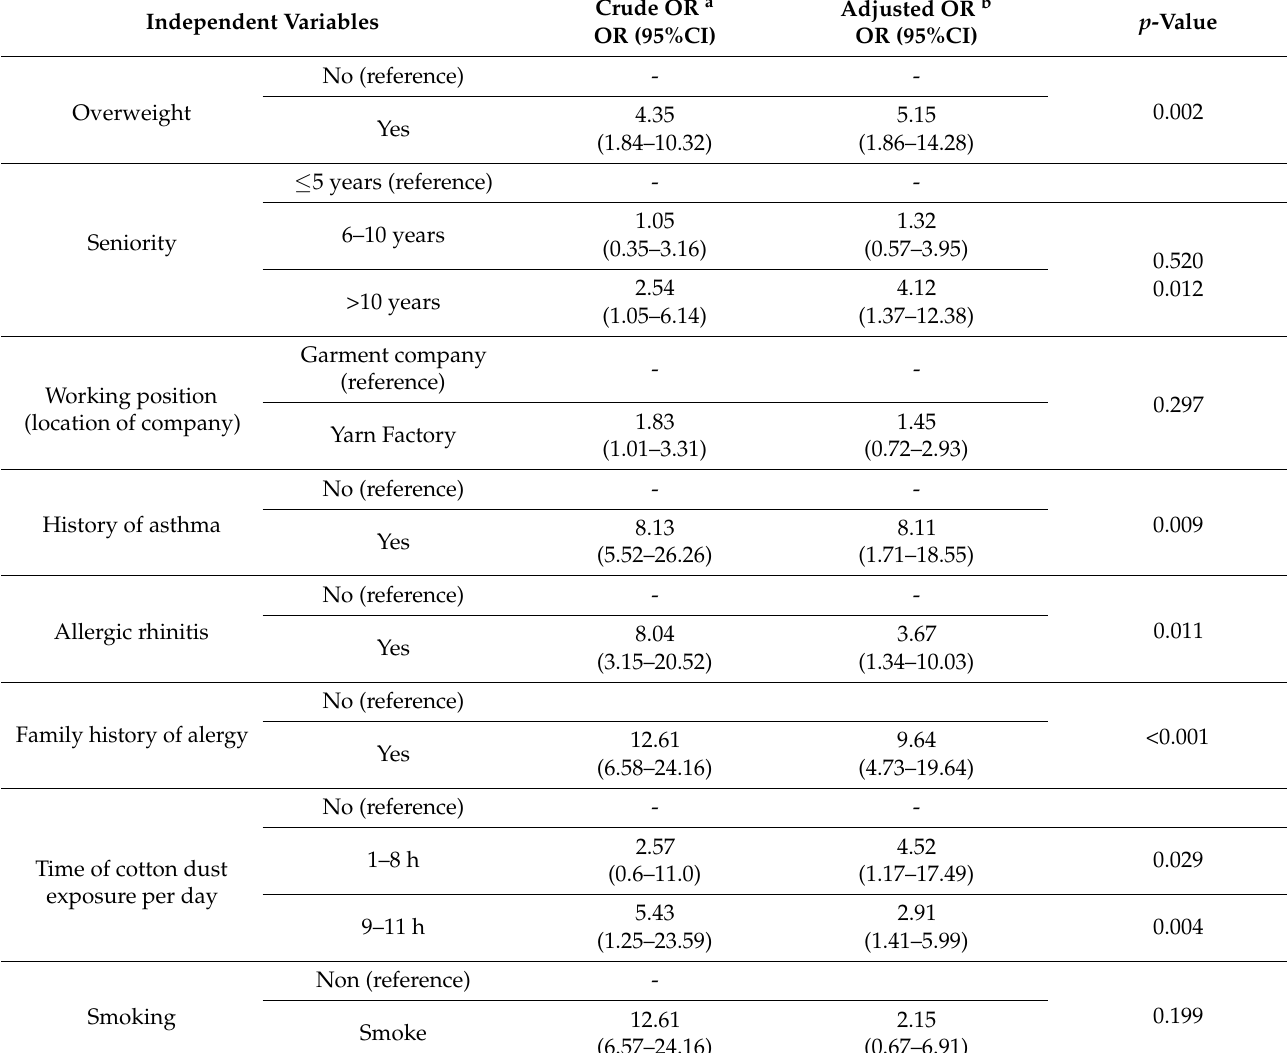
Table 2. Factors associated with allergic asthma among textile